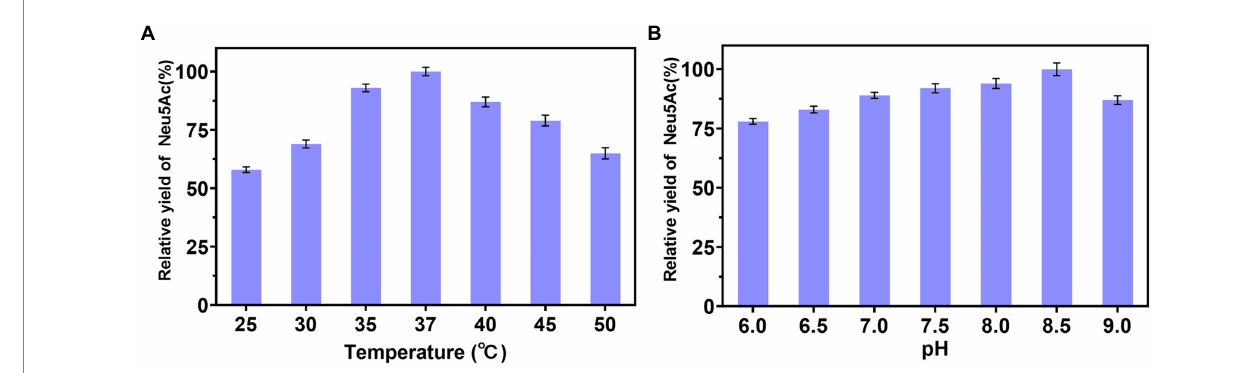
FIGURE 2 The effect of temperature and pH for the multi-enzyme cascade catalyzed. (A) Effect of temperature for the multi-enzyme cascade catalyzed synthesis. (B) Effects of pH for the multi-enzyme cascade catalyzed.